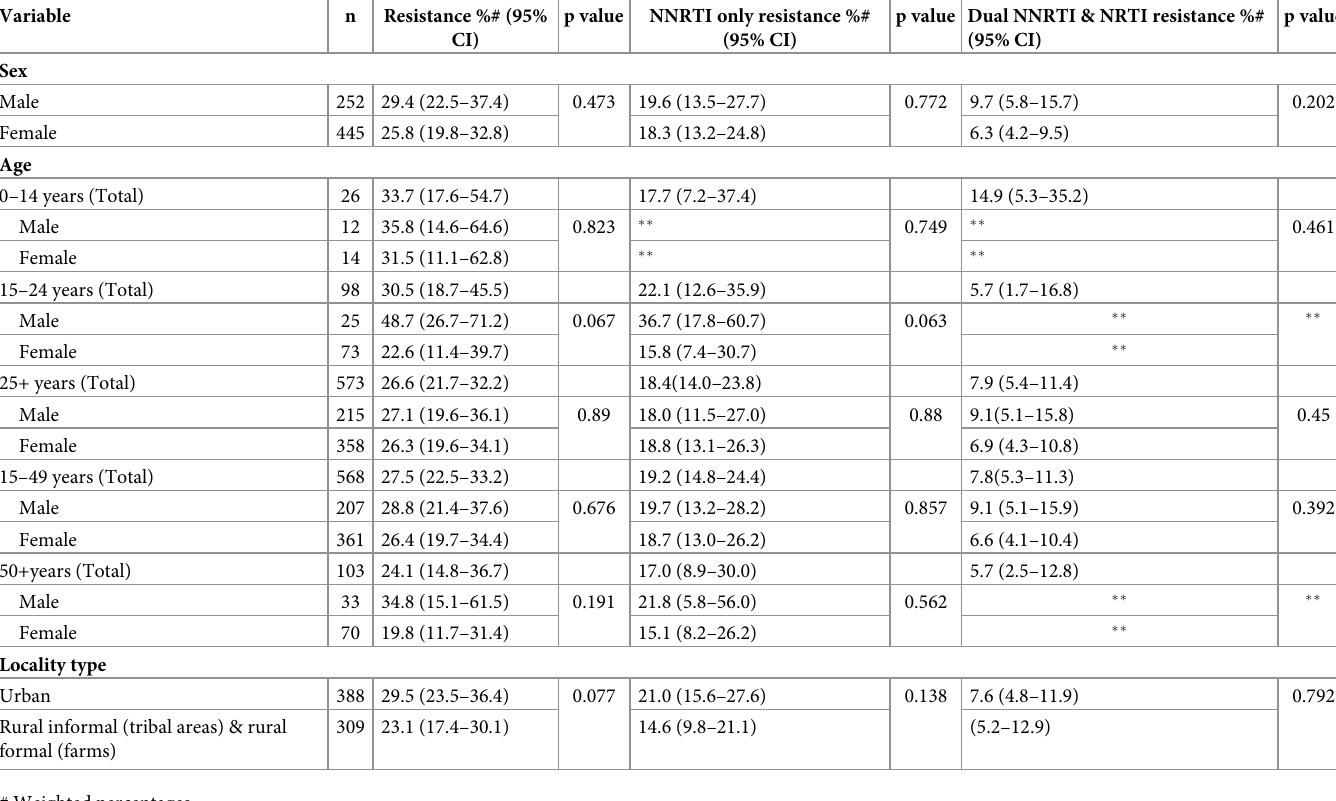
Table 2. HIV drug resistance by sex, age, and locality type, South Africa,